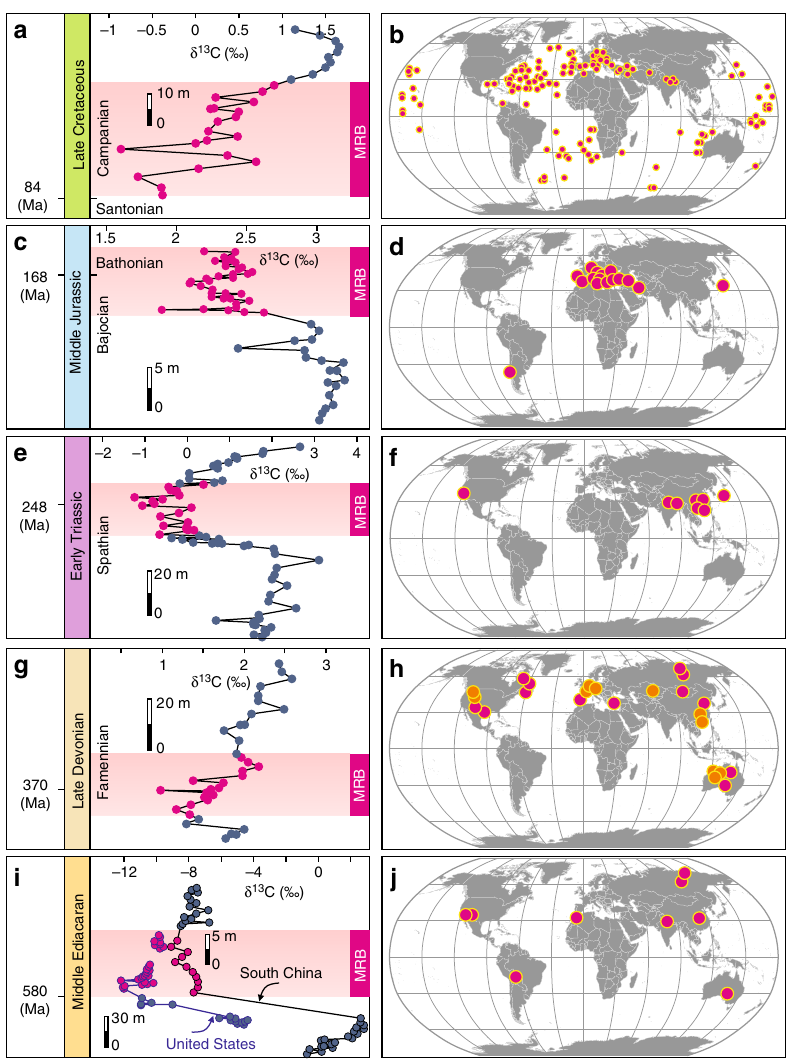
Fig. 3 Carbonate carbon isotope curves and the distribution of marine red beds. a Carbonate δ 13 C curve from the Late Cretaceous strata in Chuangde, Tibet, China. b Spatial distribution of Cretaceous MRBs. c Carbonate δ 13 C curve from the Middle Jurassic strata in Puerto Escaño, southern Spain 41 . d Spatial distribution of Jurassic MRBs. e Carbonate δ 13 C curve from the Spathian (Early Triassic) in Mingtang, South China. f Spatial distribution of Early Triassic MRBs. g Carbonate δ 13 C curve from the Famennian (Late Devonian) strata in Baisha, South China. h Spatial distribution of Late Devonian ( magenta ) and Cambrian ( orange ) MRBs. i Carbonate δ 13 C curves from the middle Ediacaran in Shijiahe, South China and northern Mesquite Mountains, United States. j Spatial distribution of Ediacaran